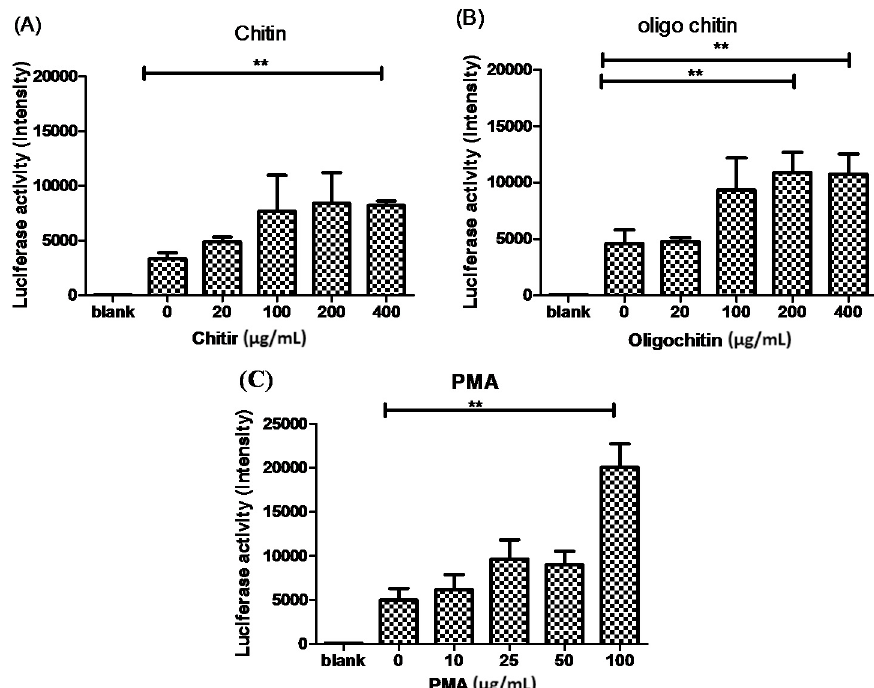
Figure 3. The effect of chitin derivative on the expression of AMCase in MLE-12 cells. The plasmid construct containing AMCase promoter and encoding luciferase was transfected to MLE-12 and RAW cells, and luciferase activity was measured after 48 h of incubation. At 24 h post-transfection, different doses of ( A ) chitin; ( B ) oligo-chitin; and ( C ) PMA were added to the cultures (** p < 0.01, paired t -test).